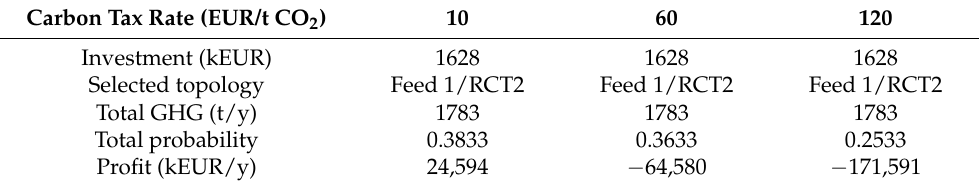
Table 6. Results of deterministic synthesis of nonintegrated process.